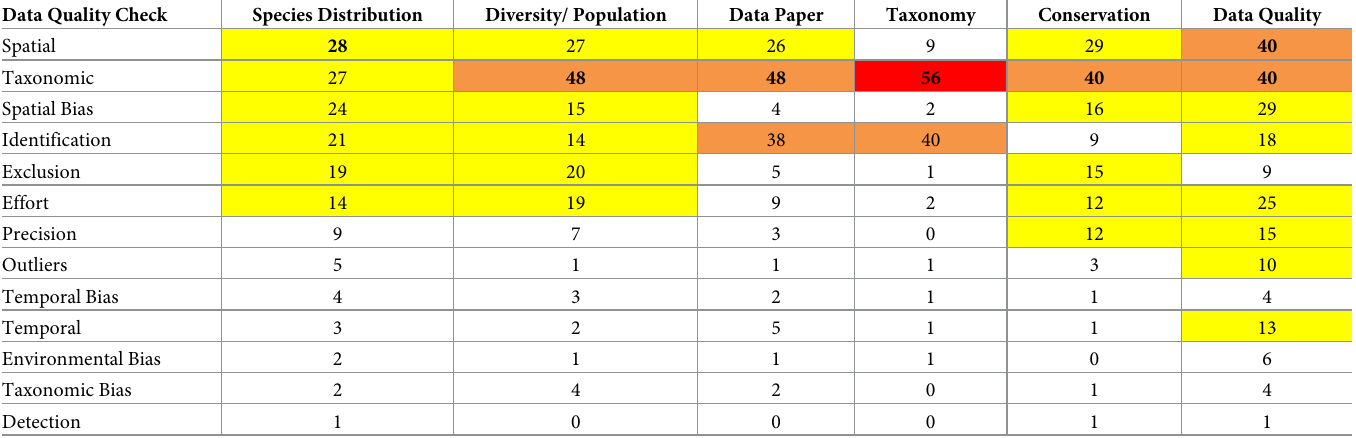
Table 7. Percentage of papers that check aspects of data quality for online occurrence data—Separated by the six top uses of these databases. Nine data types with the lowest percentages were removed from table. The top data type for each research use is bolded, and percentage values above 10% are highlighted yellow (10–29%), orange (30–49%), and red ( >